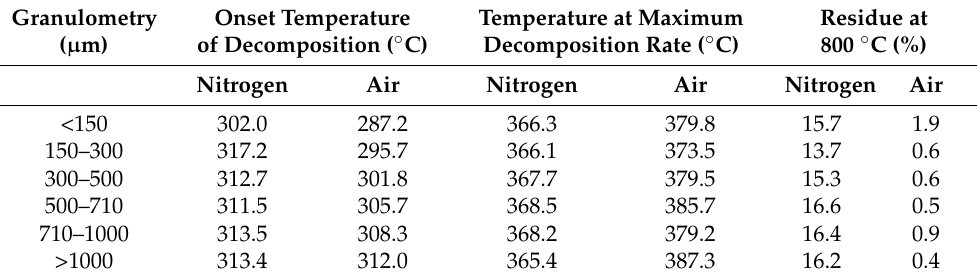
Table 2. Summary of TGA data for each wood